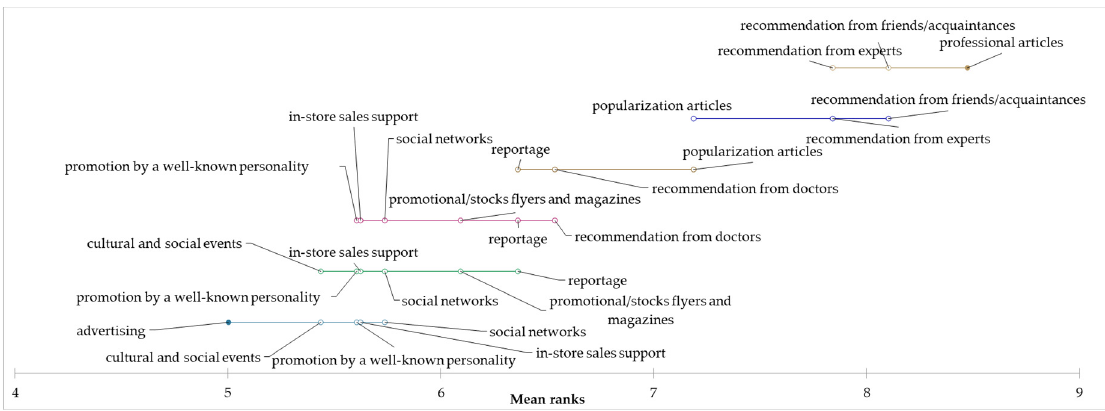
Figure 6. Differences in the evaluation of the influence of information sources on the edible mush- rooms consumption in the “heavy consumers”